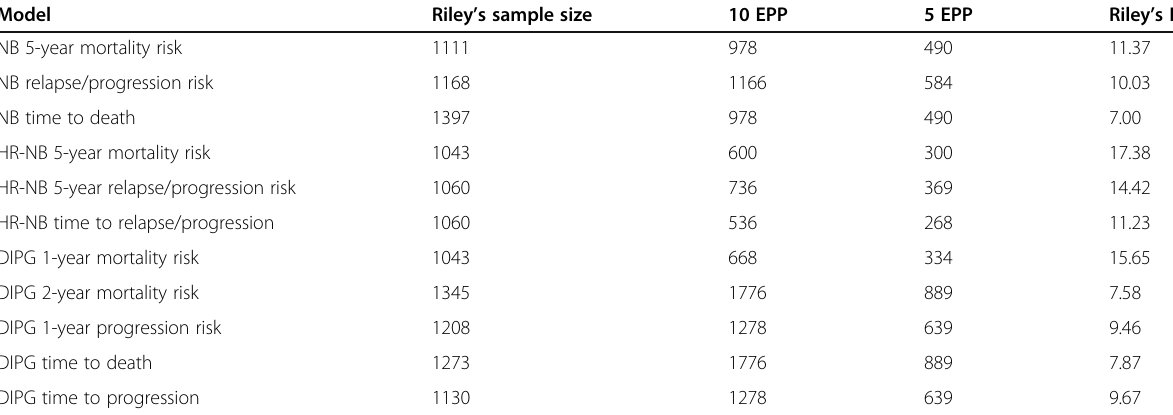
Table 3 Results of sample size calculations